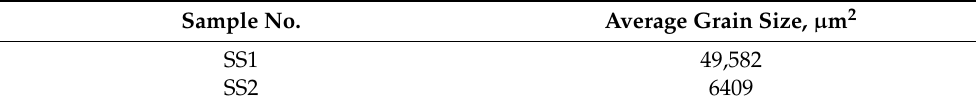
Table 4. Comparison of average grain size of both materials in samples SS1 and SS2. Sample No. Sample